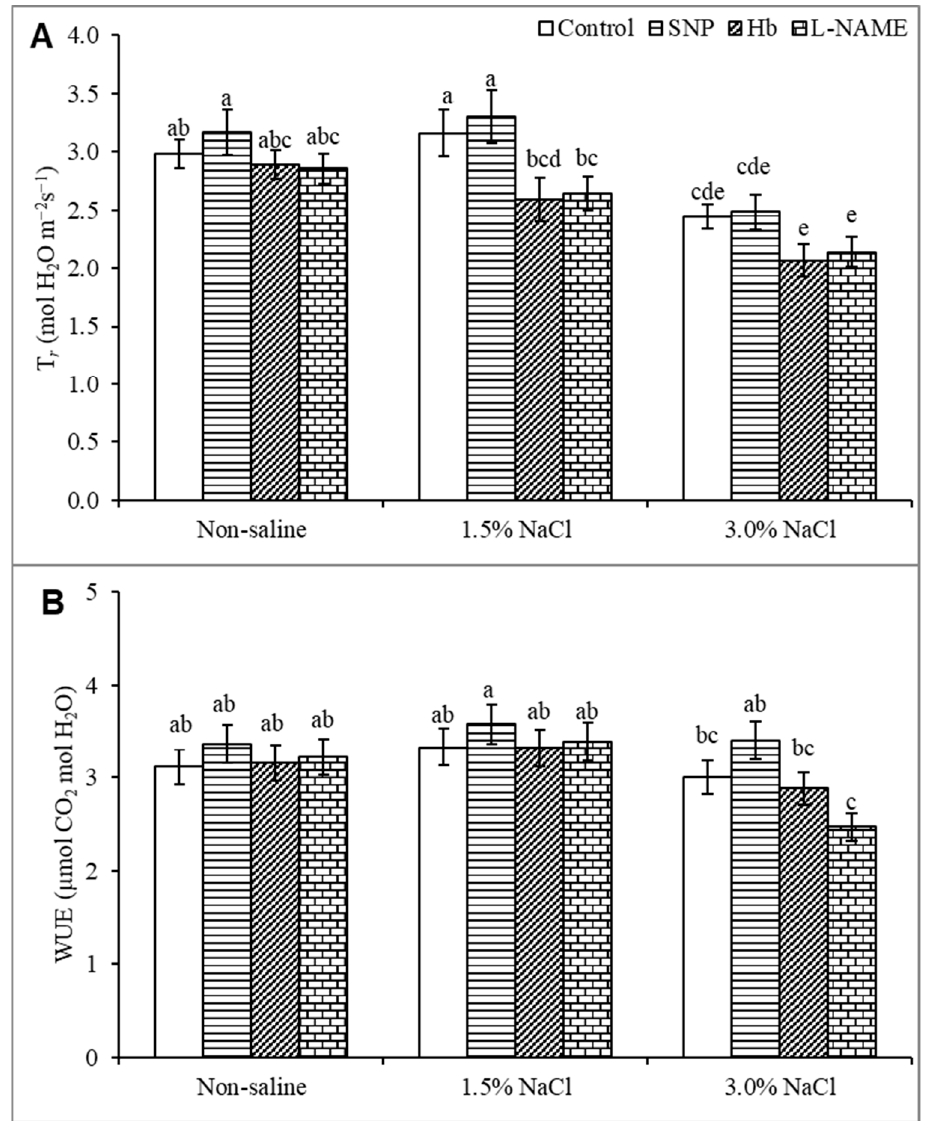
Figure 4. Transpiration rate ( A ) and water use efficiency, WUE ( B ) of Kandelia obovata treated with different salt concentrations and with 100 µM sodium nitroprusside (SNP, a NO donor), hemoglobin (Hb, a NO scavenger), or N ω -nitro- L -arginine methyl ester ( L -NAME, a NO synthase inhibitor). Mean ( ± SD) was calculated from three replicates for each treatment. Bars with different letters are significantly different at p ≤ 0.05, applying Tukey’s HSD test.